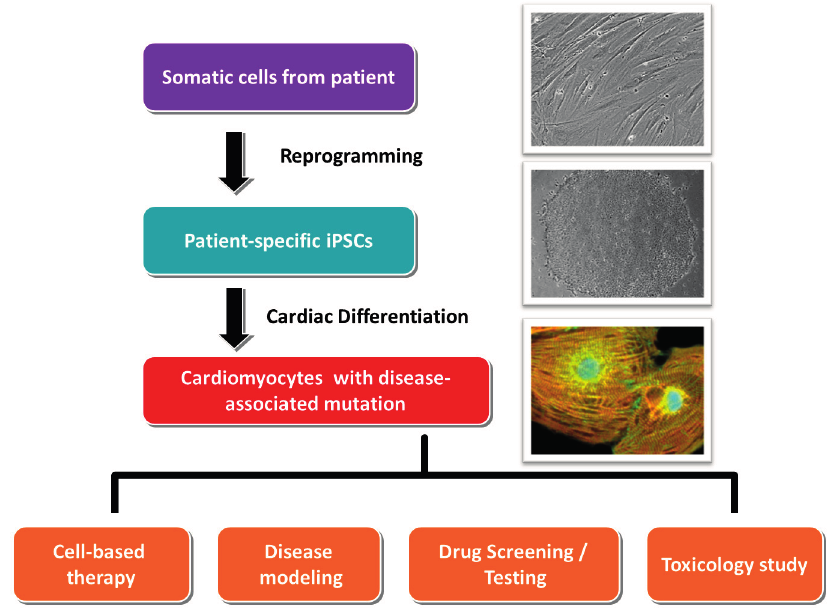
Figure 1. The clinical applications of the cardiomyocytes derived from patient-specific